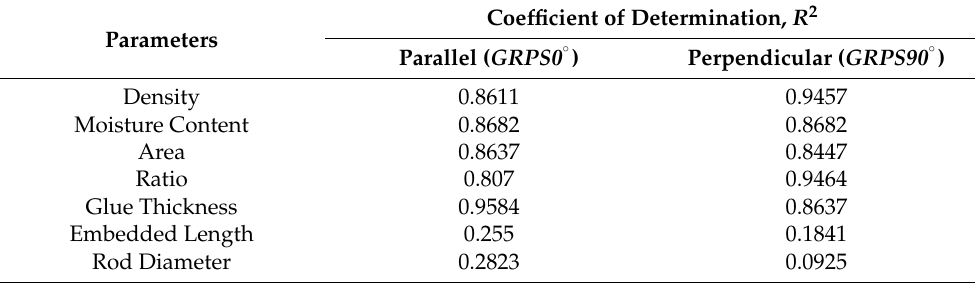
Table 3. Linear Relationships of DV and IVs for GRPS0 ◦ and GRPS90 ◦ .